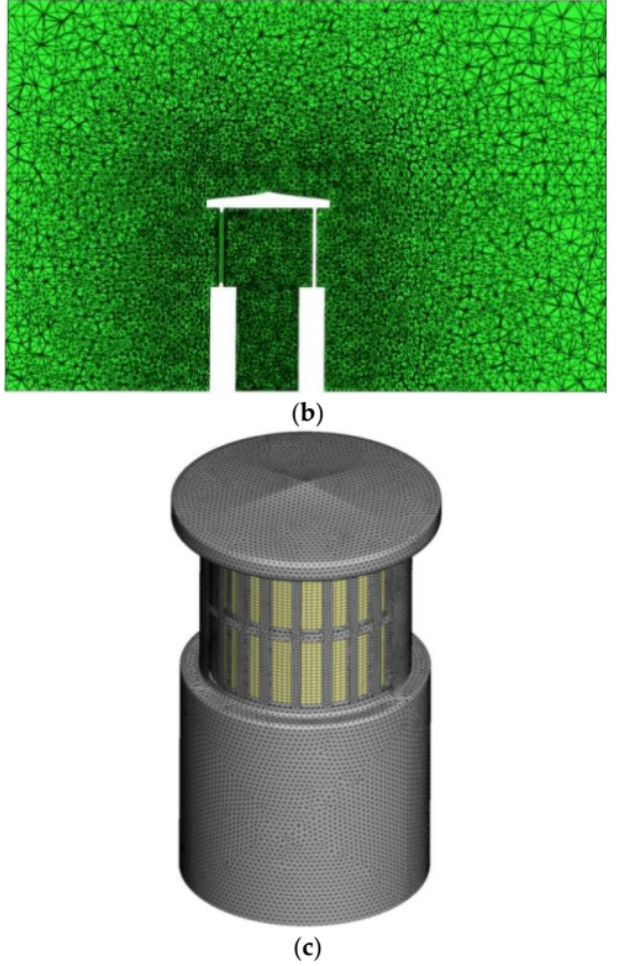
Figure 10. Grid generation on different planes: ( a ) xz-plane; ( b ) yz-plane; and ( c ) wind tower 3D